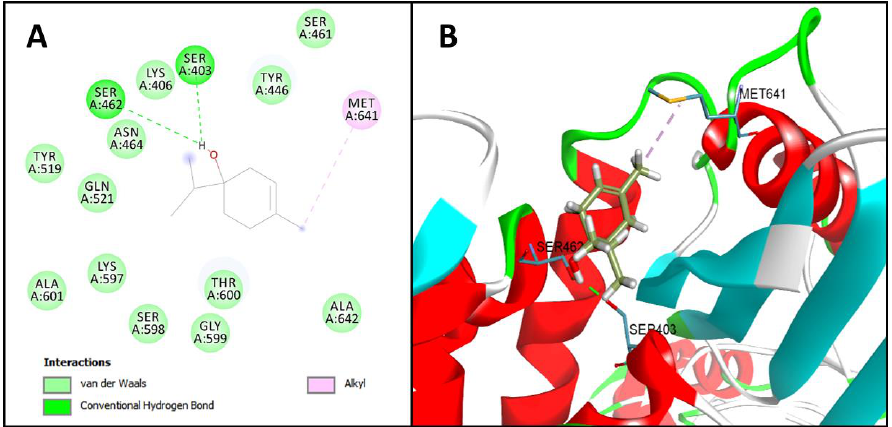
Figure 2. Two-dimensional ( A ) and three-dimensional; ( B ) representation of interactions between terpinen-4-ol and penicillin-binding protein 2a (PBP2a) active site.